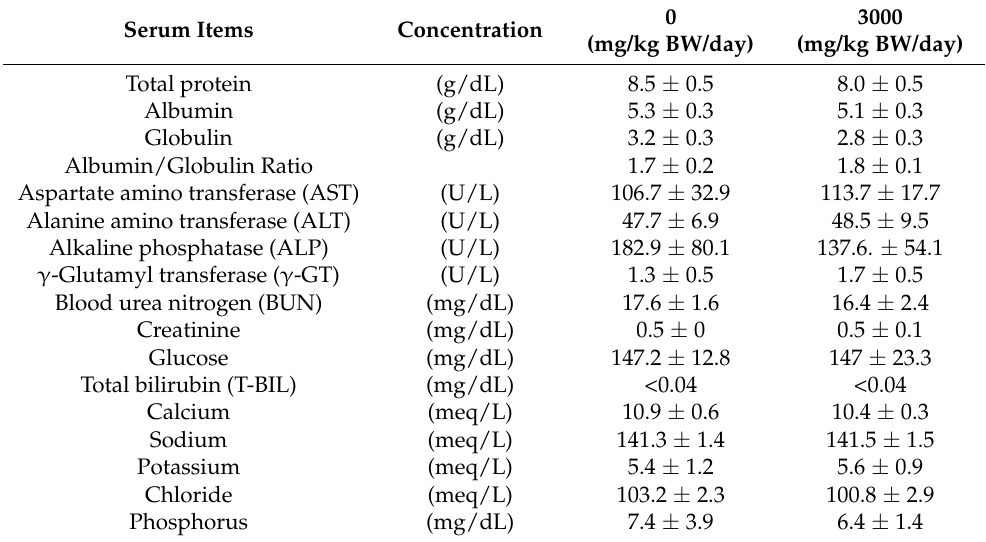
Table 5. Serum biochemistry findings in female Sprague–Dawley rats after 90 days of administration of 0 or 3000 mg/kg BW/day mycelial product obtained by white truffle solid-state fermentation. Serum